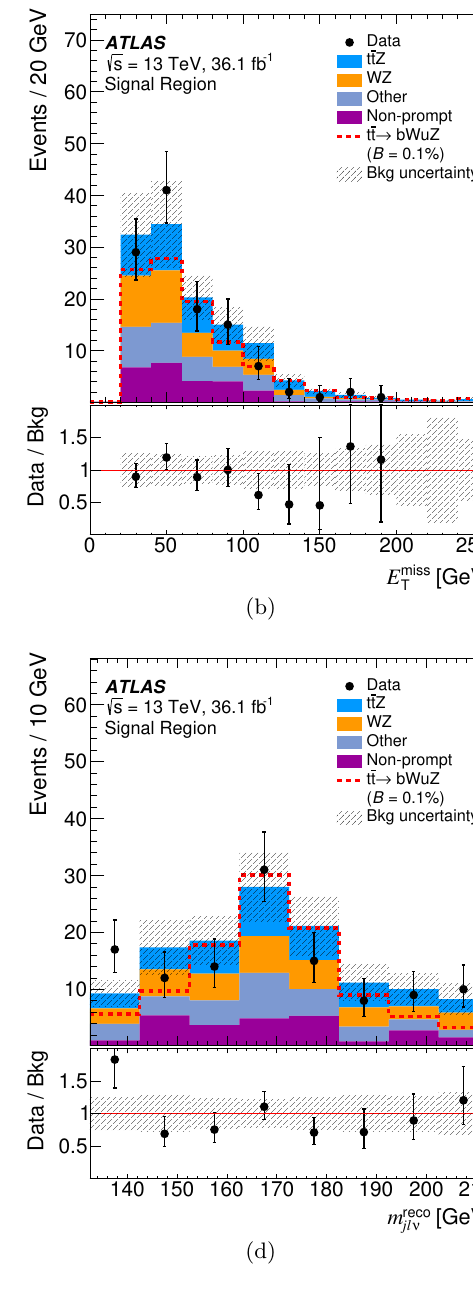
Figure 1 . Expected ((cid:12)lled histogram) and observed (points with error bars) distributions in the SR before the combined (cid:12)t under the background-only hypothesis of (a) the mass of the Z boson candidate, (b) E miss , (c) the mass of the top-quark candidate with FCNC decay, and (d) the mass of T the top-quark candidate with SM decay. For comparison, distributions for the FCNC t (cid:22) t ! bWuZ signal (dashed line), normalized to B ( t ! uZ ) = 0.1%, are also shown. The dashed area represents the total uncertainty in the background prediction. The (cid:12)rst (last) bin in all distributions includes the under(cid:13)ow (over(cid:13)ow). The \Other" category includes all remaining backgrounds described in section 3.